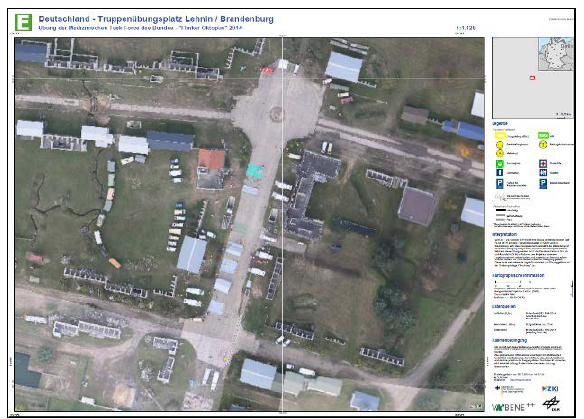
Figure 9: Map product created during the field exercise using the print service Another viewing angle was provided by images taken by a small device called Micro Aerial Vehicle (MAV). It consists of an AscTec Falcon 8 flight system and a GoPro Hero3+ camera to acquire images and videos. This perspective allows the detailed evaluation of a situation and offers a good overview at the same time (see figure 10).